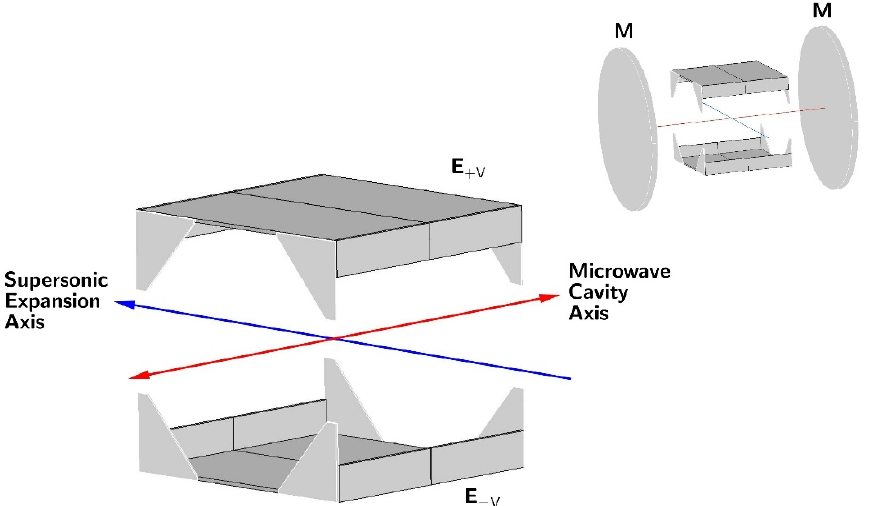
Figure 2. The electrodes ( E ) developed in Warsaw for ensuring improved electric field uniformity for Stark measurements on supersonically expanded samples and (upper right) their placement between the 50 cm diameter mirrors ( M ) of the Fabry-Perot resonator used for microwave measurements. The electrodes are in the form of 28 × 28 cm parallel plates, placed 27 cm apart, with additional side plates designed by numerical computations to focus the electric field in the interaction volume between the supersonic expansion plume and the microwave resonator mode. The main and side plates can be split into two parts for insertion and assembly through the easily accessible (15 cm and 10 cm diameter) central ports of the spectrometer chamber.